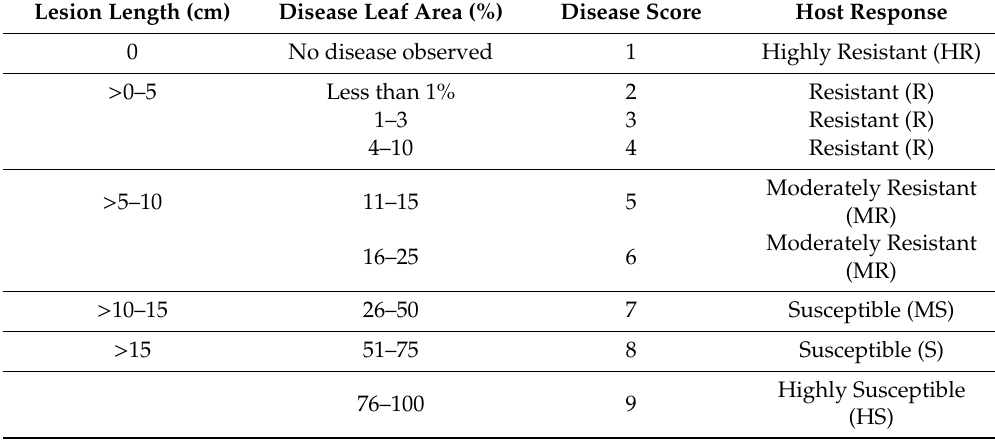
Table 2. Standard evaluation system (SES) for bacterial leaf blight (BLB)